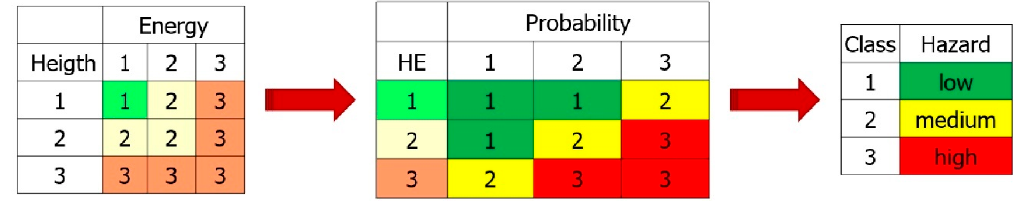
Figure 9. Criteria of classification used to create the rockfall hazard map.